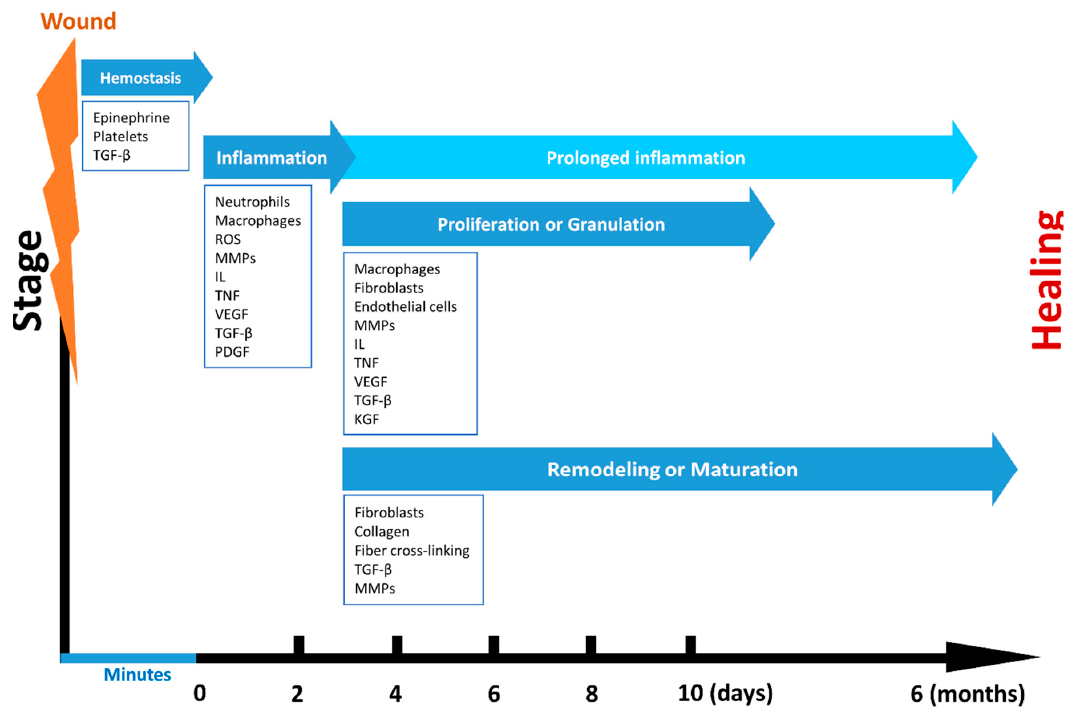
Figure 2. Wound healing phases.